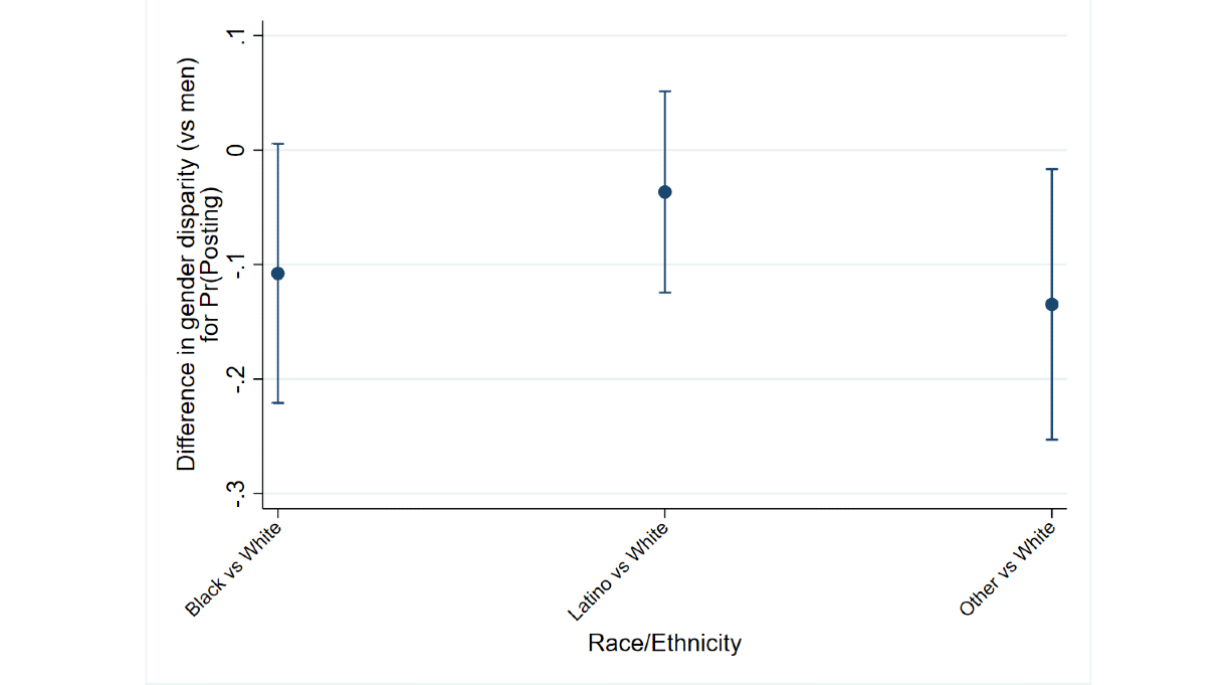
Figure 2. Differences in the gender divide in posting (95% CI) among respondents who identified as black, Latino, or other races/ethnicities relative to that of respondents who identified as white. Pr(Posting): probability of posting.